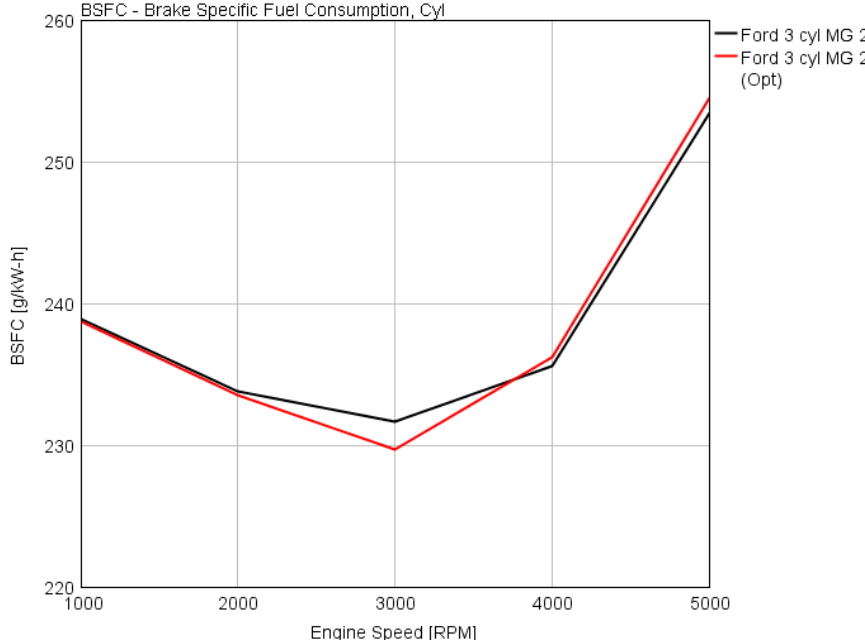
Figure 21. Brake Torque graphs for the initial (black) and optimized (green) EAT 2 kW models.